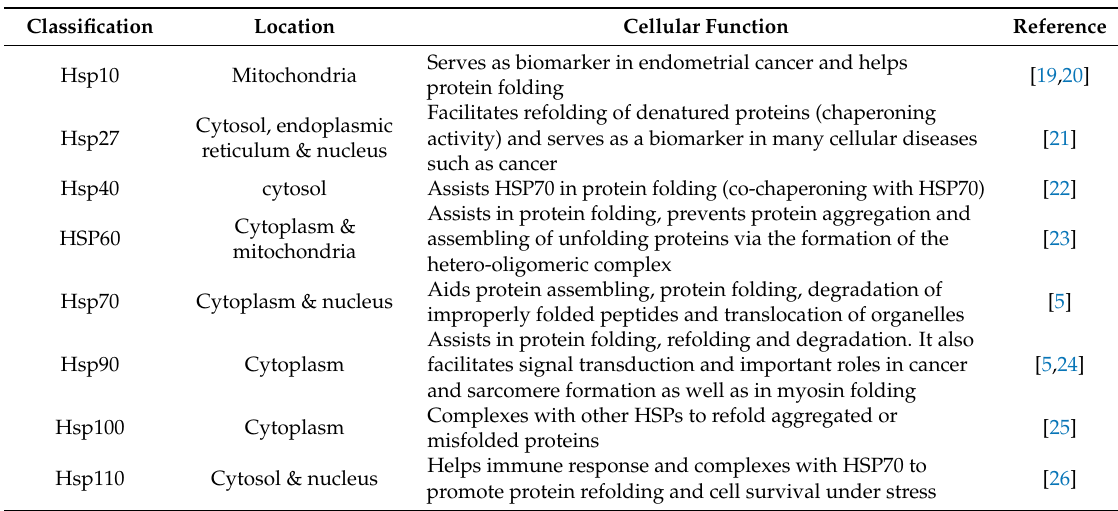
Table 1. Classification of heat shock protein